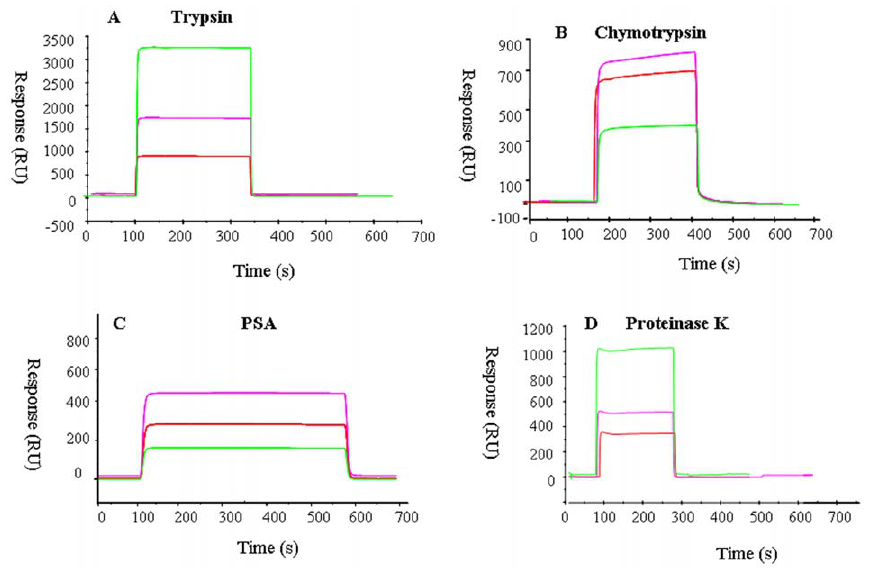
Figure 8. SPR sensograms of HE-4 interaction with serine proteases. HE-4 immobilised on CM5 chip as described in methods. Concentration of HE-4 was fixed at 10 m M. Concentrations of serine proteases (from top to bottom) were 300, 150, and 75 nM respectively. ( A ) Trypsin-HE-4 interaction. ( B ) Chymotrypsin-HE-4 interaction. ( C ) PSA- HE-4 interaction. ( D ) Proteinase K- HE-4 interaction.